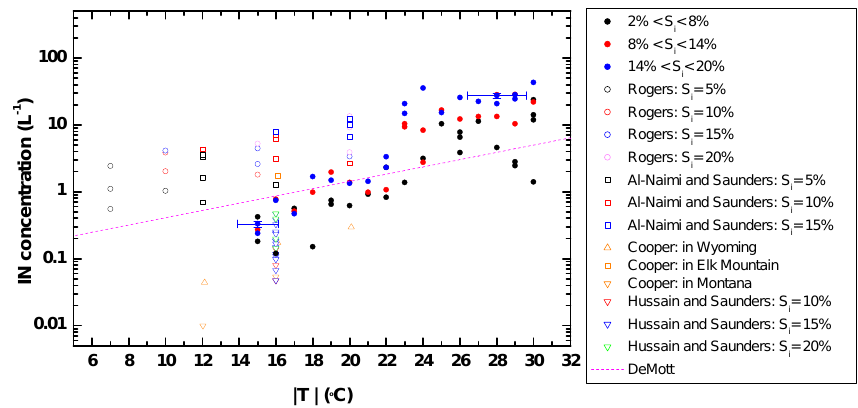
Fig. 5. Data of IN concentration vs. supercooling, for different S i . The current results and those of different authors are represented together with the fitting curve proposed by DeMott et al.